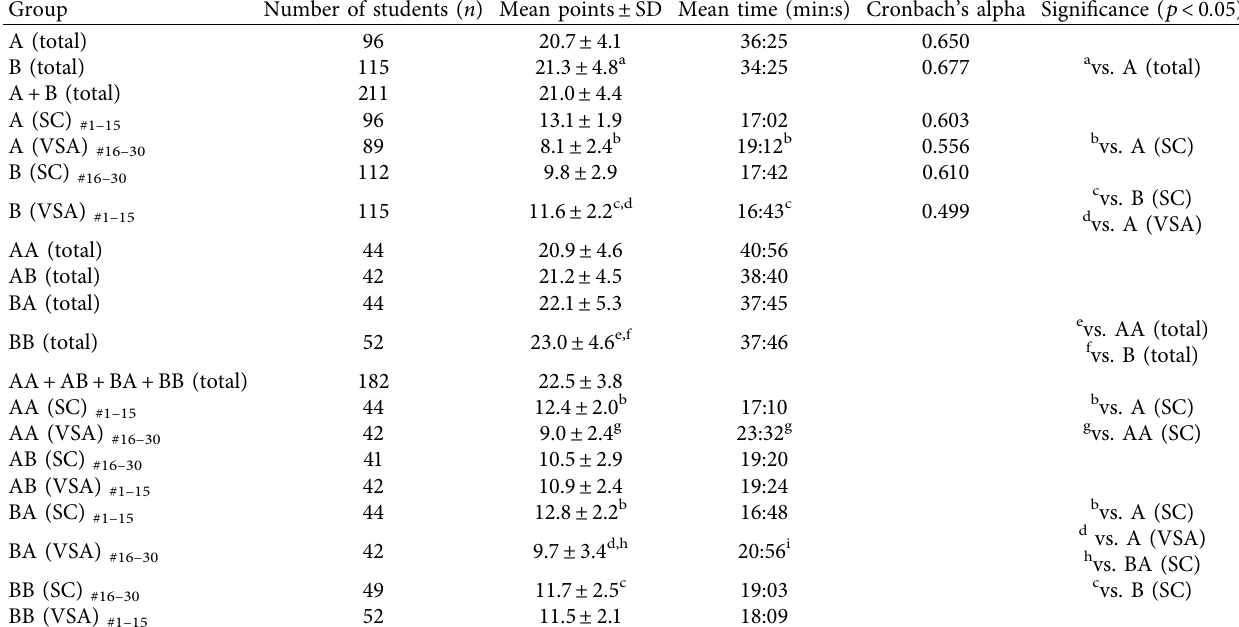
Table 1: Test results of all groups of students.